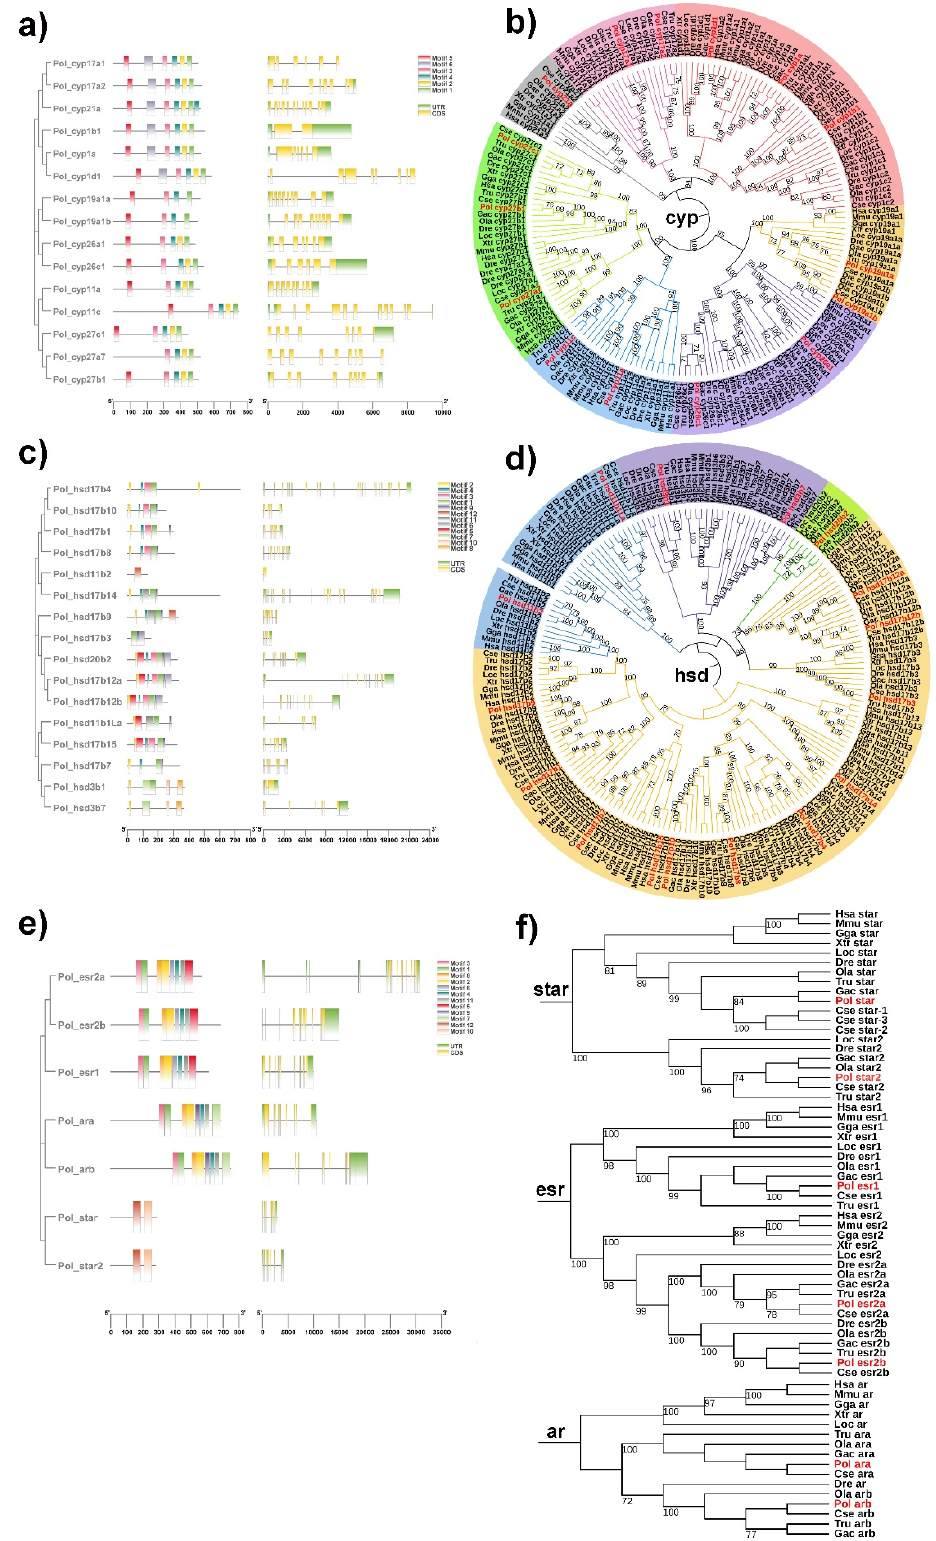
Figure 2. Characterization of steroidogenic proteins. The conserved motif and structure of ( a ) cyp, ( c ) hsd, ( e ) star, esr and ar in P. olivaceus , and the phylogeny of ( b ) cyp, ( d ) hsd, ( f ) star, esr and ar in selected vertebrates. The phylogenic trees were constructed with a bootstrap of 1000 times. The sub-families of cyp and hsd were labeled with different background colors, and the P. olivaceus proteins were highlighted in red.